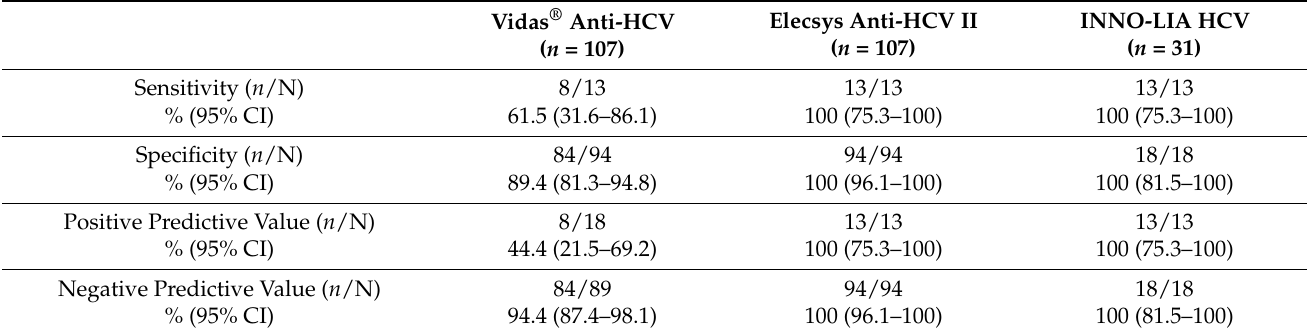
Table 2. Characteristics of three serological assays for hepatitis C diagnosis on DBS. Sensitivity, specificity, positive predictive value (PPV), and negative predictive value (NPV) (95% confidence interval) for VIDAS ® Anti-HCV (bioMerieux), Elecsys ® Anti-HCV II (Roche) and INNO-LIA HCV (Fujirebio).